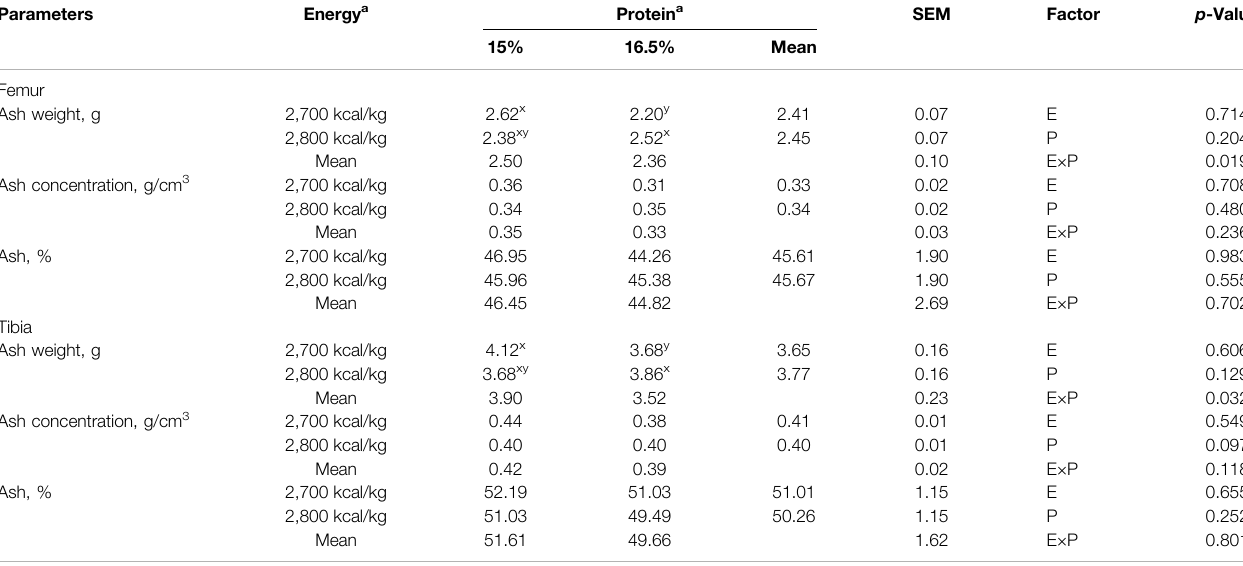
TABLE 9| Effect ofdietary metabolizable energy(E)and crudeprotein (P)levelsduring theprelay period (15 – 20 weeksofage)onbone ashin layinghens at72 weekofage. Parameters Energy a Protein a SEM Factor